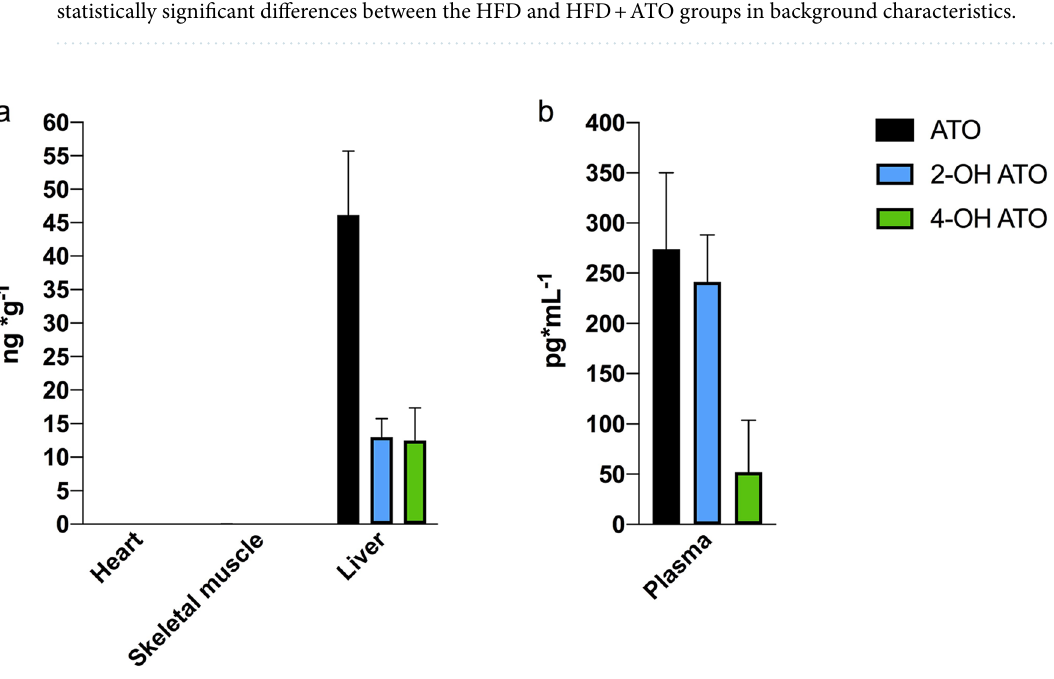
Figure 1. Concentrations of atorvastatin and active metabolites of atorvastatin in Göttingen minipigs treated with atorvastatin (HFD + ATO, n = 7). ( a) Tissue concentrations (ng/g) analysed in heart muscle, skeletal muscle and liver, of atorvastatin calcium salt (ATO) and two metabolites; 2-hydroxy atorvastatin dihydrate monosodium salt (2-OH ATO) and 4-hydroxy atorvastatin disodium salt (4-OH ATO). The liver was the only tissue with detectable concentrations. ( b) Plasma concentrations (pg/mL) of ATO, 2-OH ATO and 4-OH ATO) in the minipigs. Data are means ±